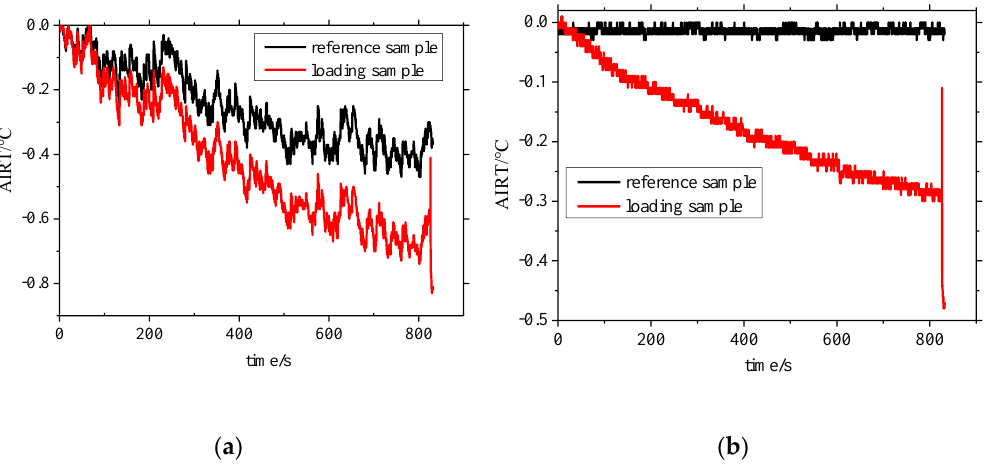
Figure 8. AIRT of sample A 1 before and after denoising processes. ( a ) Before denoising. ( b ) After denoising.